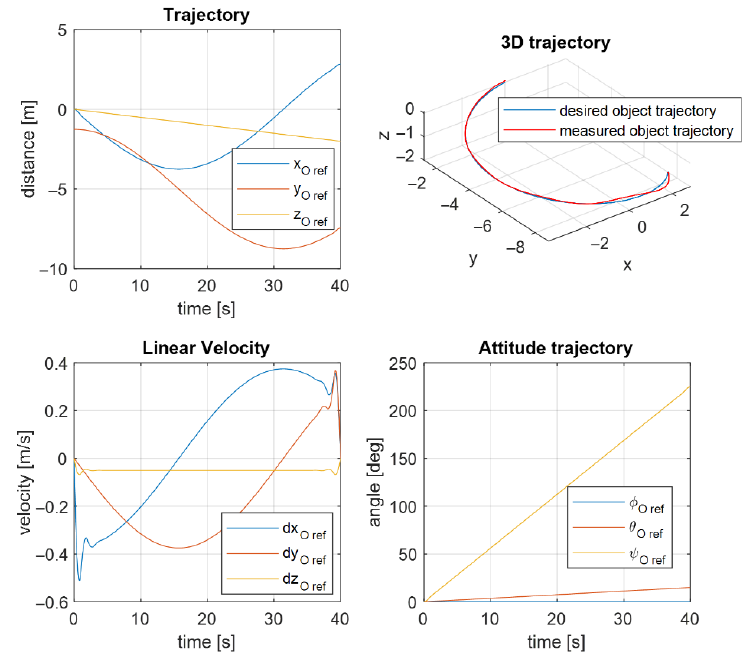
Figure 10. Desired object trajectory.